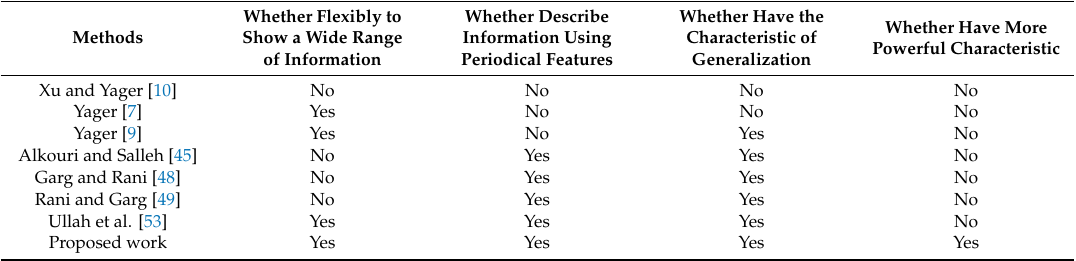
Table 13. Characteristic comparison between the proposed methods with the existing